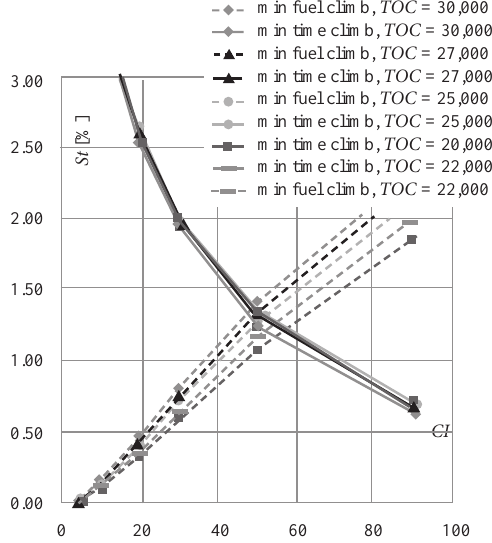
Fig. 5. Percentage of saving for climb phase. Costs